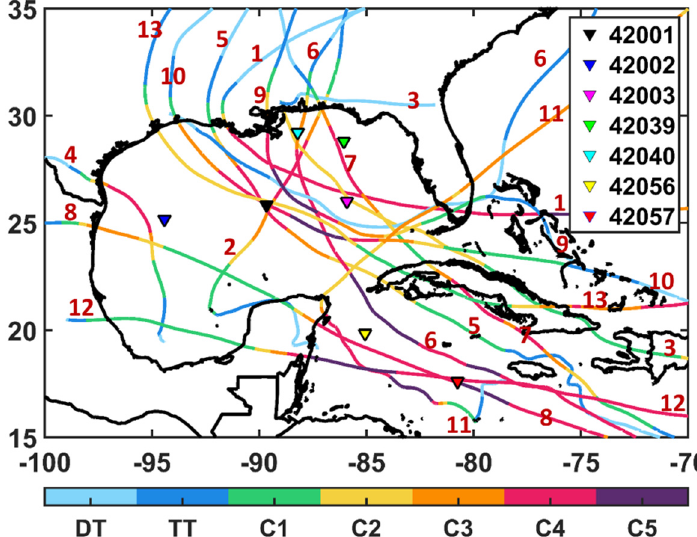
Figure 1. Buoy locations (colored triangles) and 1-h cubic spline interpolated tropical cyclone trajectories and category (colored lines). The number denotes the tropical cyclone as follows: (1) Andrew 1992; (2) Opal 1995; (3) Georges 1998; (4) Bret 1999; (5) Lili 2002; (6) Ivan 2004; (7) Dennis 2005; (8) Emily 2005; (9) Katrina 2005; (10) Rita 2005; (11) Wilma 2005; (12) Dean 2007; and (13) Ike 2008.